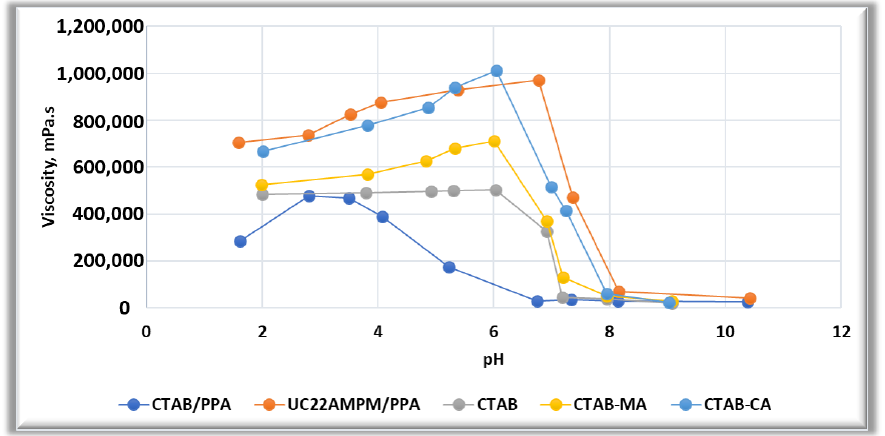
Figure 15. The effect of pH on the apparent viscosity for the three types of CTAB based (CTAB, CTAB-MA, and CTAB-CA) VES-fluids when compared to the literature’s data of Wang et al.